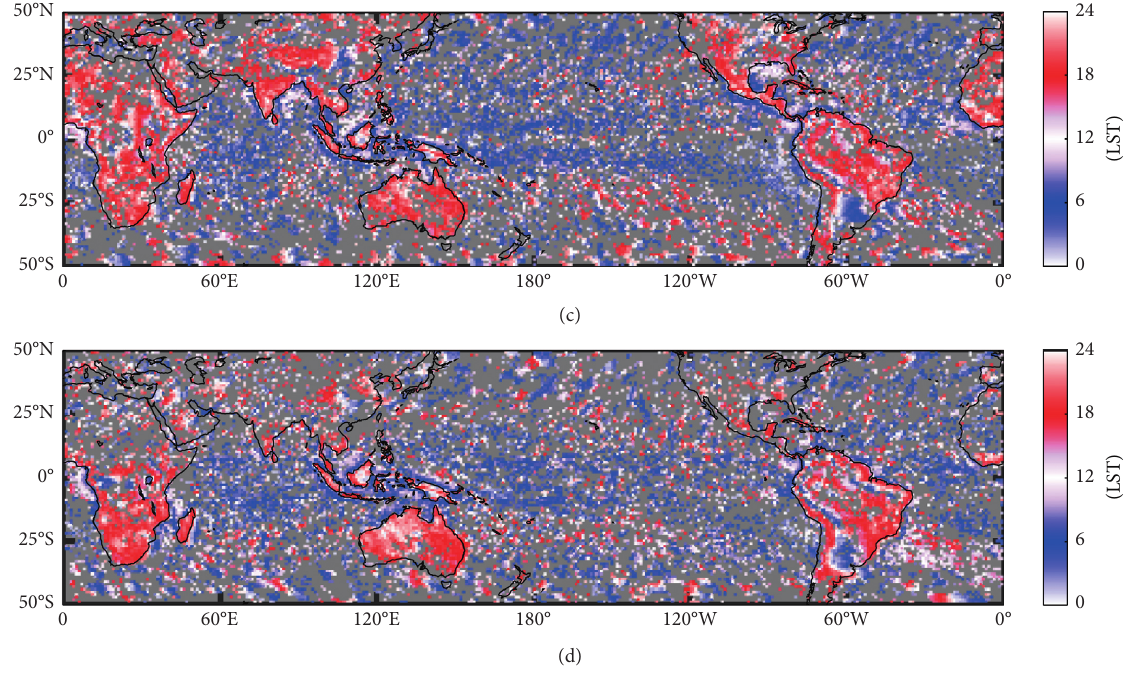
Figure 8: Peak time of the diurnal harmonics from the IMERG V06B product in (a) MAM; (b) JJA; (c) SON; and (d) DJF. The grey areas indicate the diurnal harmonics were not statistically significant at the 90% confidence level in either IMERG or TMPA